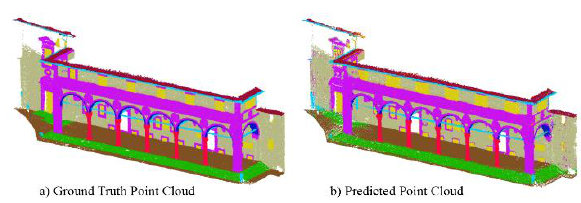
Figure 4 . Comparison between a) the Ground Truth point cloud, b) the Predicted point cloud.